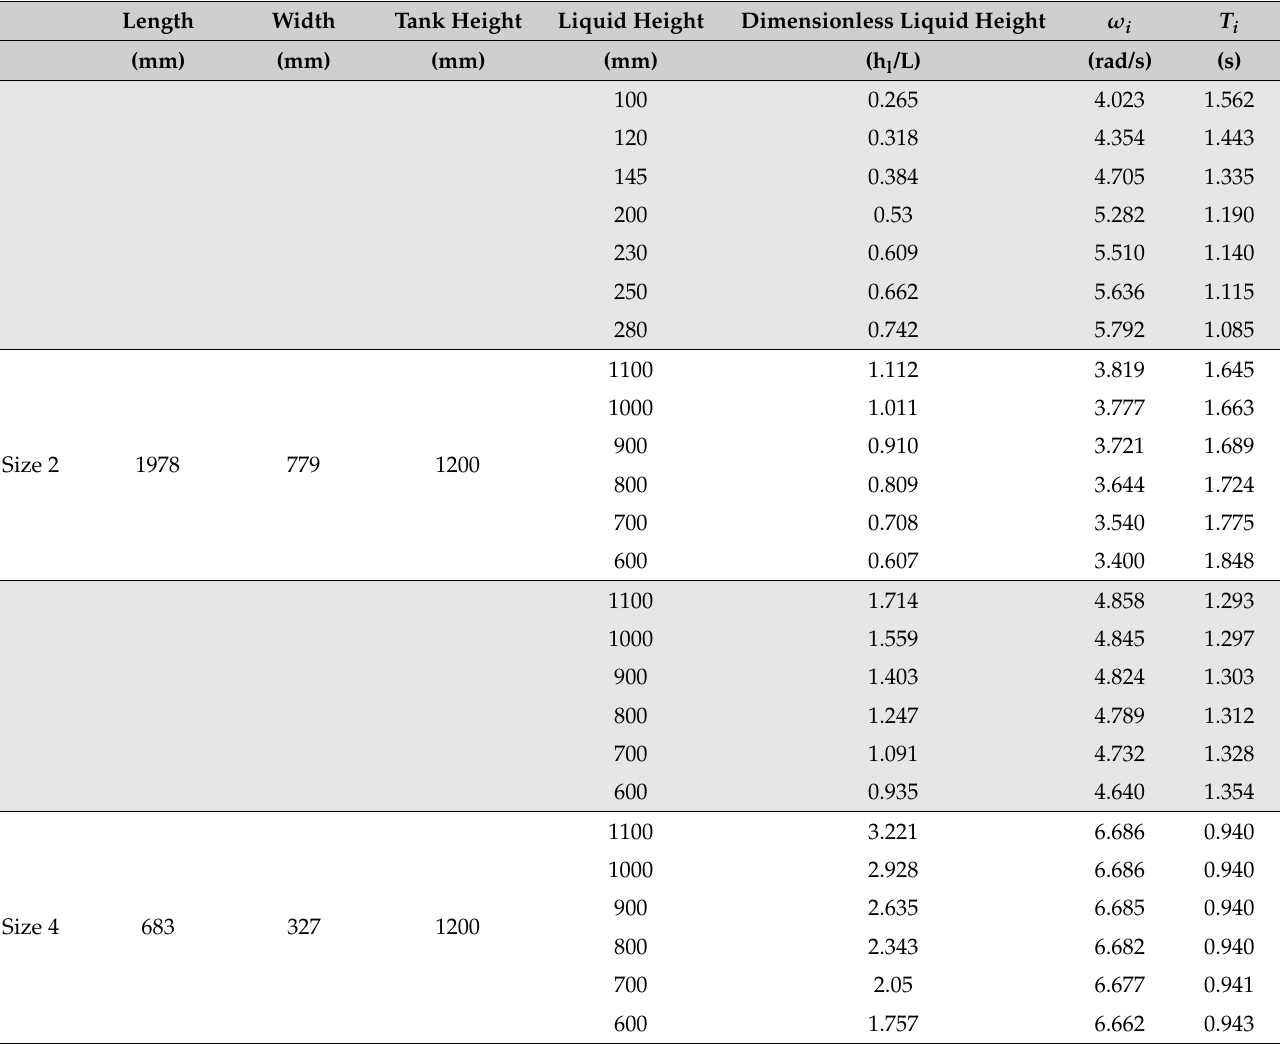
Table 2. Frequency applied to each tank based on the tank size and liquid